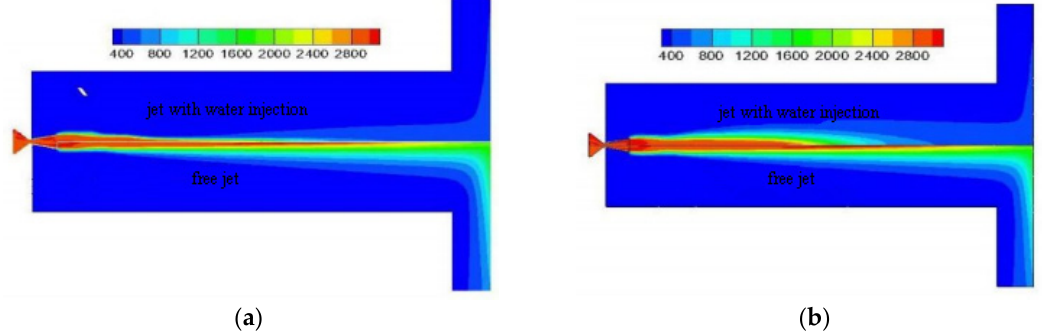
Figure 12. ( a ) Temperature comparison between free jet and jet with water injection in the XOY plane; ( b ) Temperature comparison between free jet and jet with water injection in the XOZ plane.